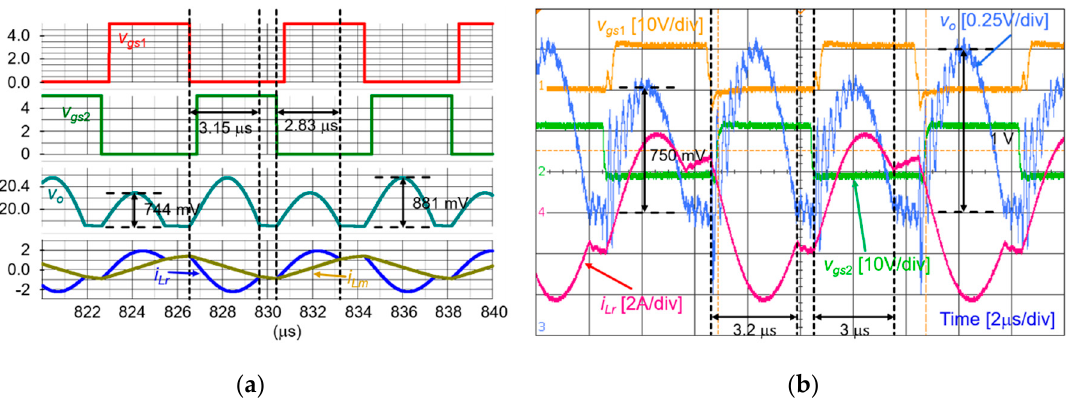
Figure 19. Mismatched secondary side leakage inductances at full load in steady-state operation ( a ) simulation results and ( b ) experiment results.